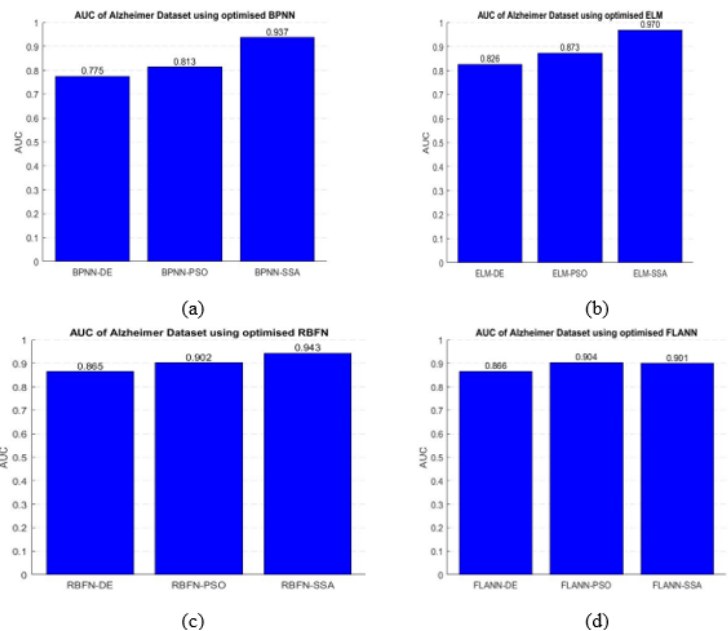
Figure 13. Comparison of AUC values for Alzheimer’s dataset obtained using models ( a ) BPNN, ( b ) ELM, ( c ) RBFN, or ( d )